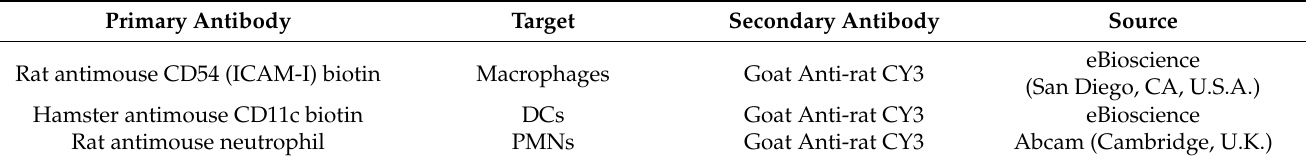
Table 2. Antibodies used for immunofluorescence